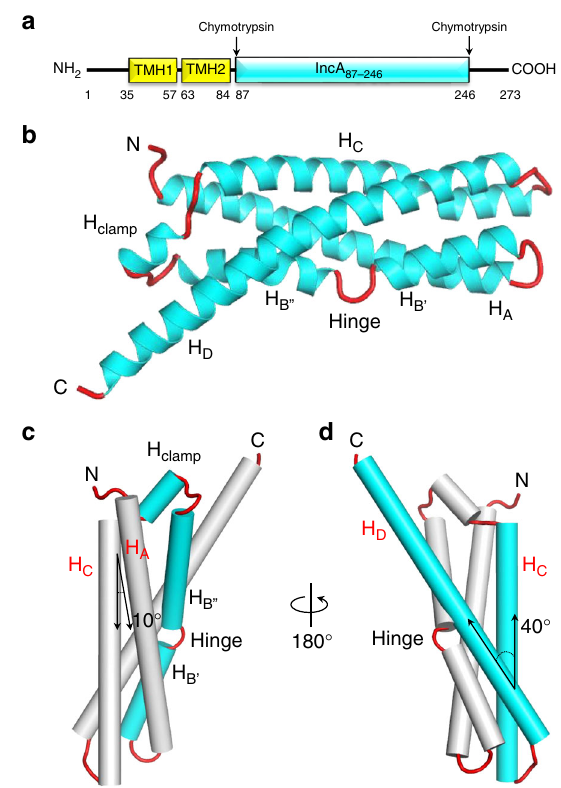
Fig. 1 The cytosolic domain of IncA folds into a non-canonical α -helical bundle. a Schematic diagram of C. trachomatis IncA domain organization. Transmembrane helices (TMH) were predicted using the HMMTOP server 50 . The stable core encompassing residues 87 – 246 (IncA 87 – 246 ) was identi fi ed by limited proteolysis of the cytosolic domain as described 8 . b Ribbon diagram of IncA 87 – 246 with α -helices and random coiled linkers colored in cyan and red, respectively. c , d Two rotated views of IncA 87 – 246 , orthogonal to the representation in b , with α -helices shown as cylinders. c highlights the segmented structure of the helix H B , while d shows the relative angle between helices H C and H